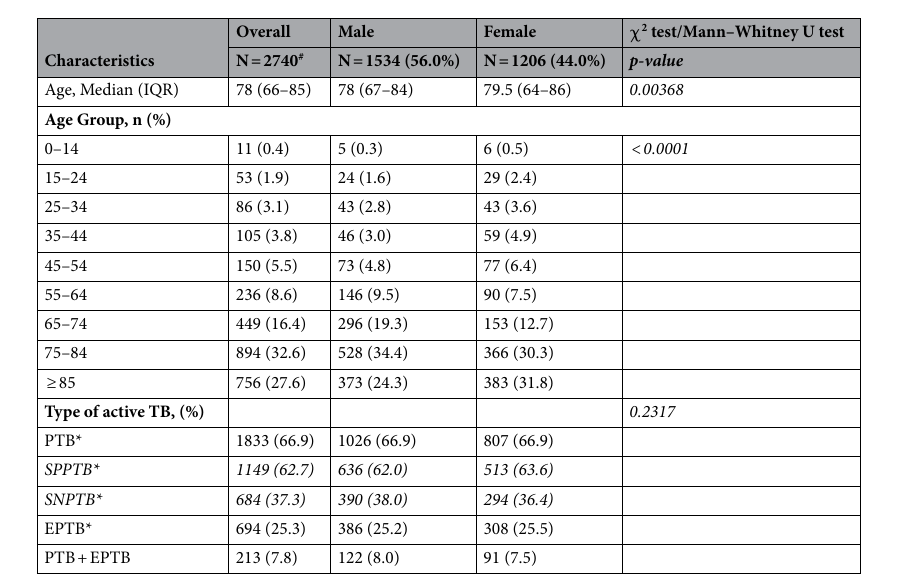
Table 2. Characteristics of 2740 active TB in Nagasaki Prefecture, 2007 to 2018, stratified by sex. N = 2740 # : The 2740 active TB cases described in Table 2 are the sum of 2738 Active TB and 2 Dead (one confirmed of PTB and another of PTB + EPTB) previously mentioned in Table 1; PTB*: pulmonary tuberculosis; SPPTB*: